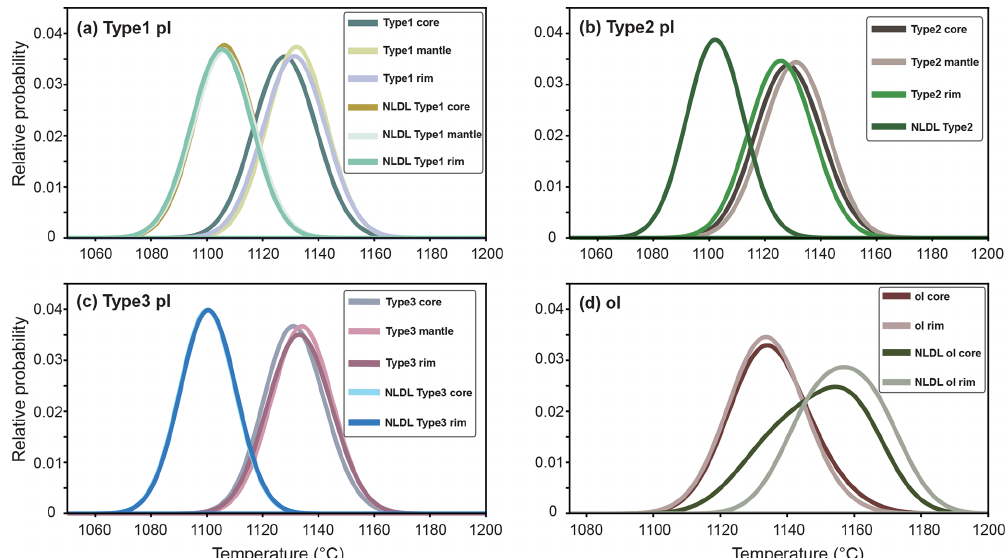
Figure 10. Kernel density estimates (KDEs) of thermometric calculation results for plagioclase (a–c) and olivine (d) in the WVF. Crys- tallization temperatures are calculated following the plagioclase–melt thermometer of Putirka (2008) and olivine–melt thermometer of Putirka